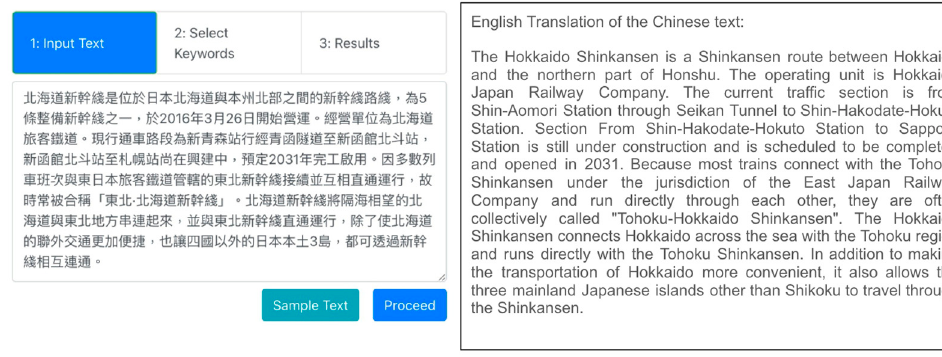
Figure 2. Step 1: user needs to input a passage.